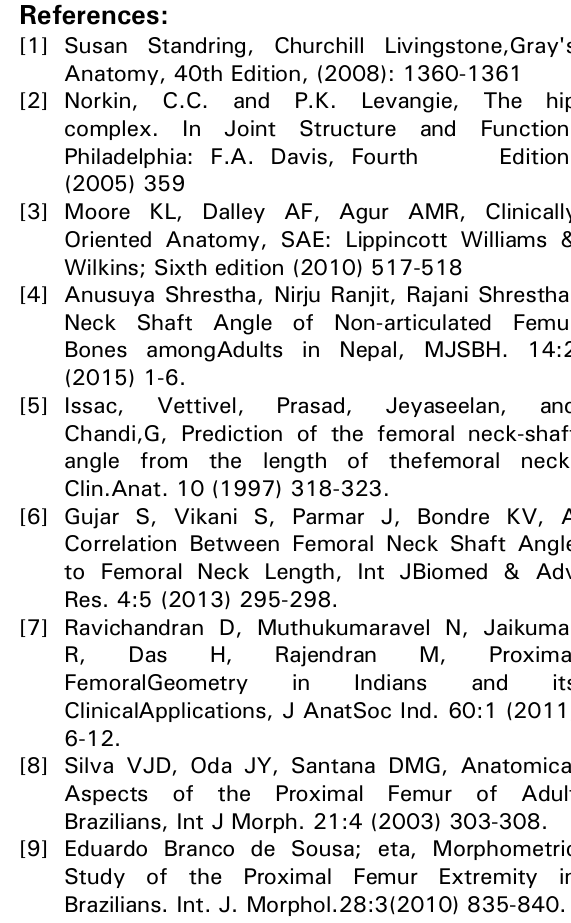
Table 2: Femoral Angle of Inclination in different